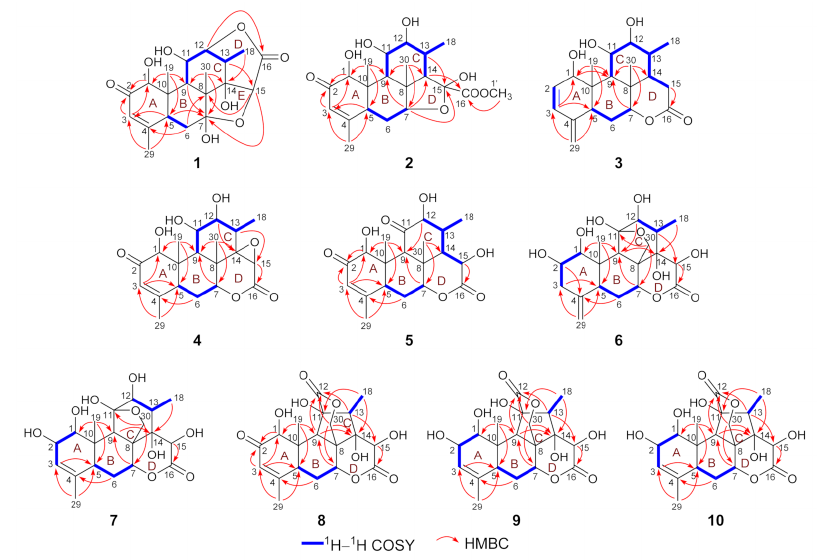
Figure 2. Key 1 H– 1 H COSY and HMBC correlations of compounds 1 – 10